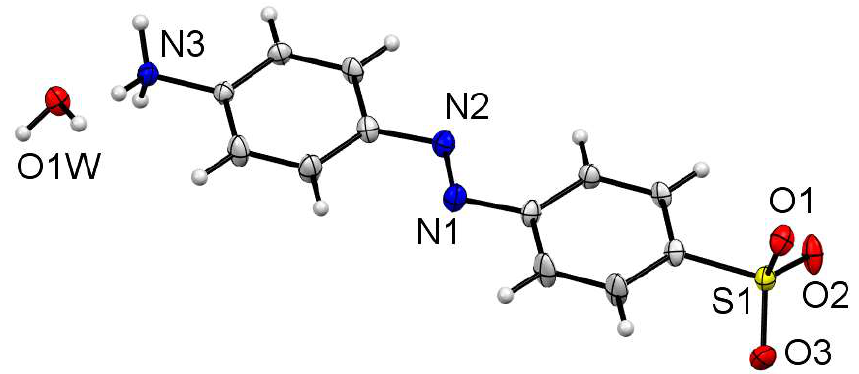
Figure 2. Contents of the asymmetric unit of free acid species H2 .H 2 O. Similar zwitterionic forms with protonation at N1 are the commonest free acid types observed herein. Here and below, displacement ellipsoids are drawn at the 50% probability level and H atoms are shown as small spheres of arbitrary size. This atom-numbering ee is used throughout the comparative discussion of azo geometries below.